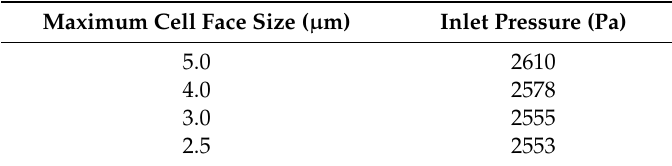
Table 4. Grid dependency study results ( D = 50 µ m, Re ∞ =